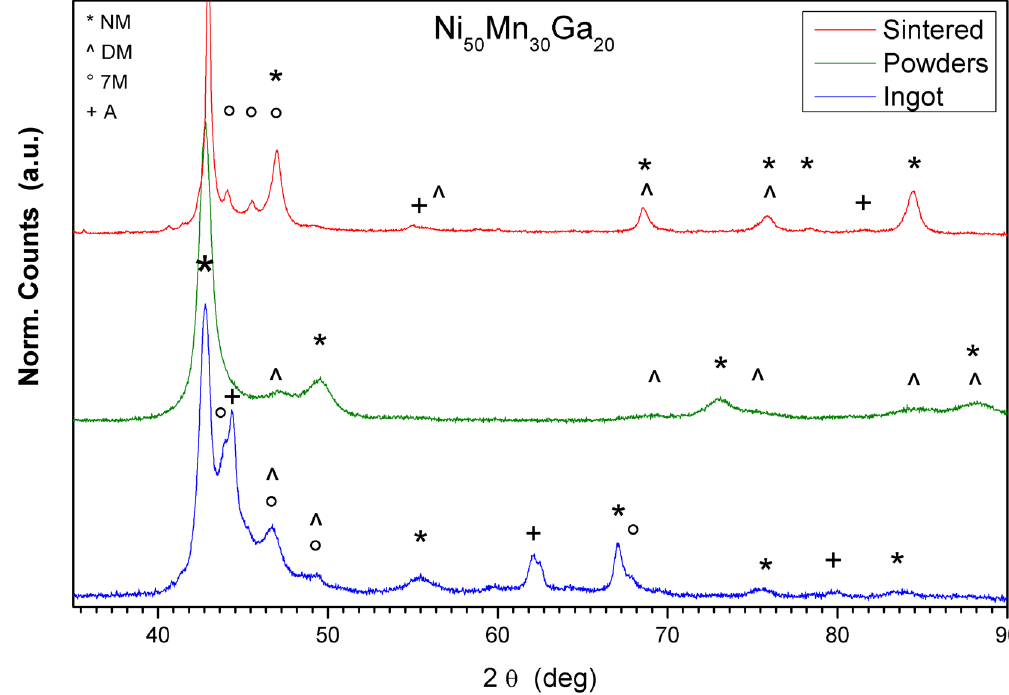
Figure 4. Normalized and translated XRD patterns collected at 25 °C from as cast ingot, milled powders, and sintered pellet (sample C). Different symbols are used to identify the peaks corresponding to the non-modulated martensite (NM), the distorted monoclinic structure (DM), the long range modulated martensite (7M) and the austenite (A) observed in the samples.